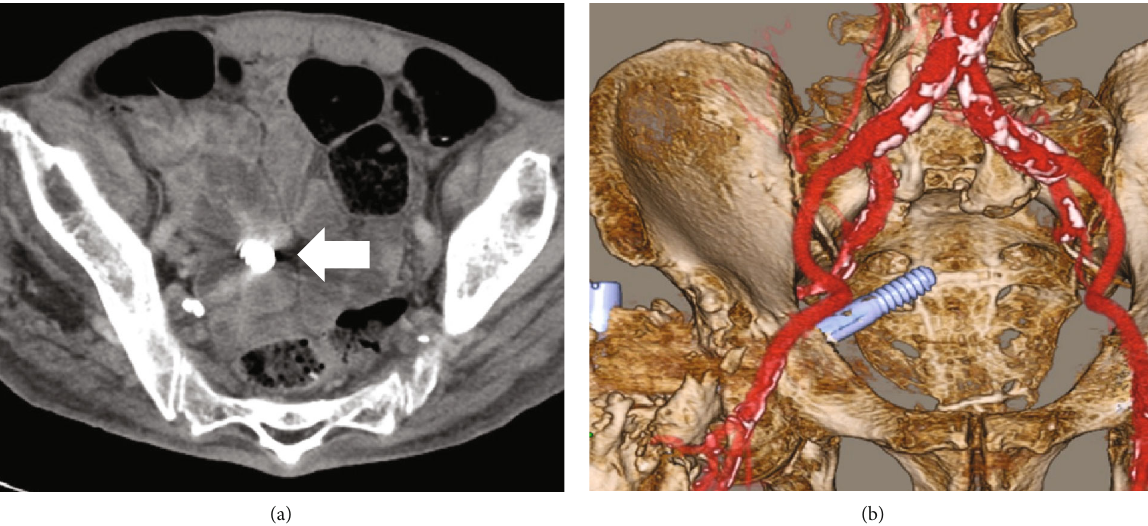
Figure 4: A contrast-enhanced computed tomography scan showing the lag screw located deep in the pelvis, between the internal and external iliac vessels, and tangent to the intestine. (a) Axial view (arrow, lag screw) and (b) reconstructed 3D